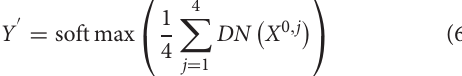
TABLE 1 | Mean segmentation results (in percent) of the contrast experiments and ablation studies (mean ± SD). Methods